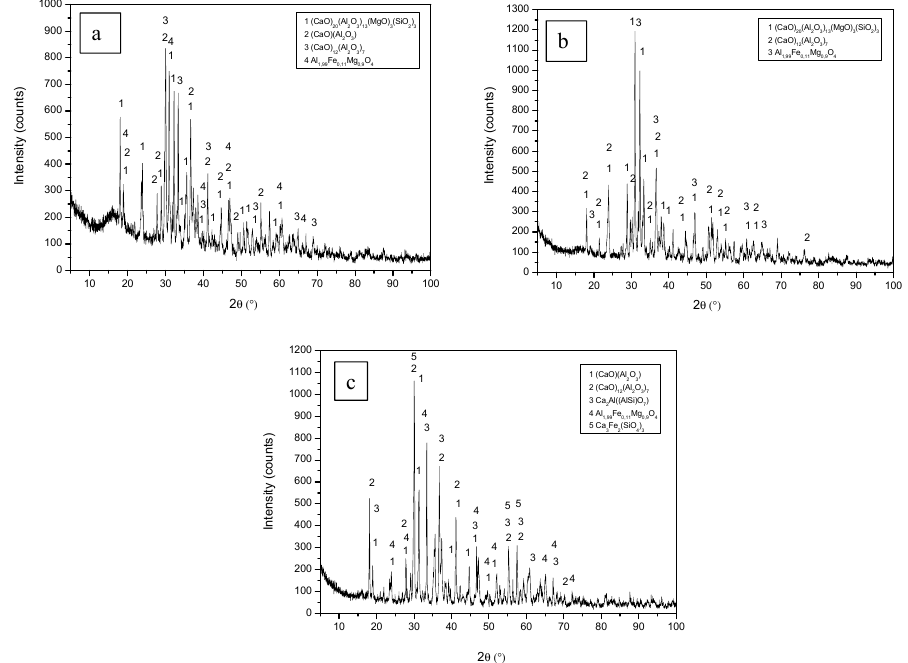
Figure 2. XRD di ff raction pattern of the sintered materials at 1300 ◦ C; ( a ) Al 2 O 3 / CaO 1:1 Al1 S; Figure 2. XRD diffraction pattern of the sintered materials at 1300 °C; ( a ) Al 2 O 3 /CaO 1:1 Al1 S; ( b ) ( b ) Al 2 O 3 / CaO 1:1 Al2 S y; ( c ) Al 2 O 3 / CaO 1:1 Al3